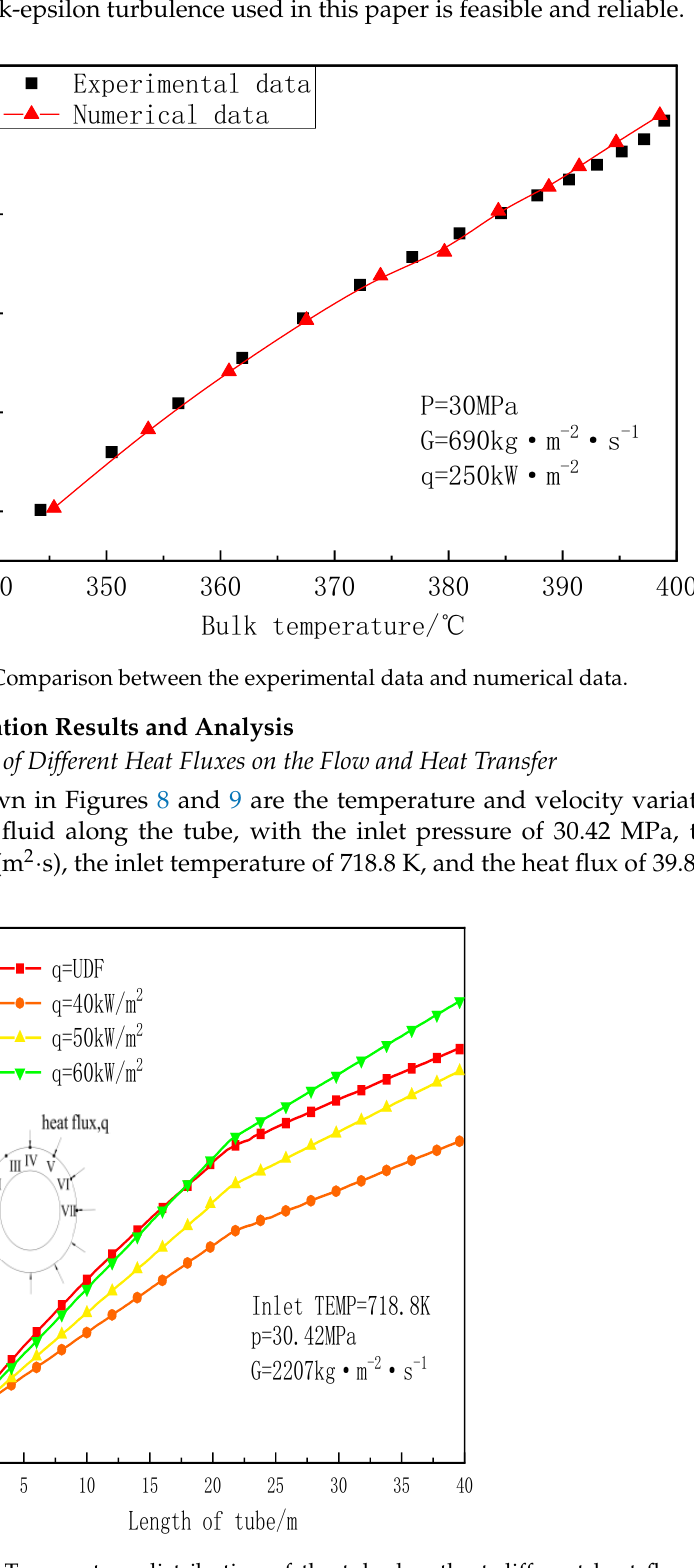
Figure 8. Temperature distribution of the tube length at different heat fluxes ( p = 30.42 MPa, G = 2207 kg/ ( m 2 ·s), q = 39.8~71.2 kw/m 2 ).